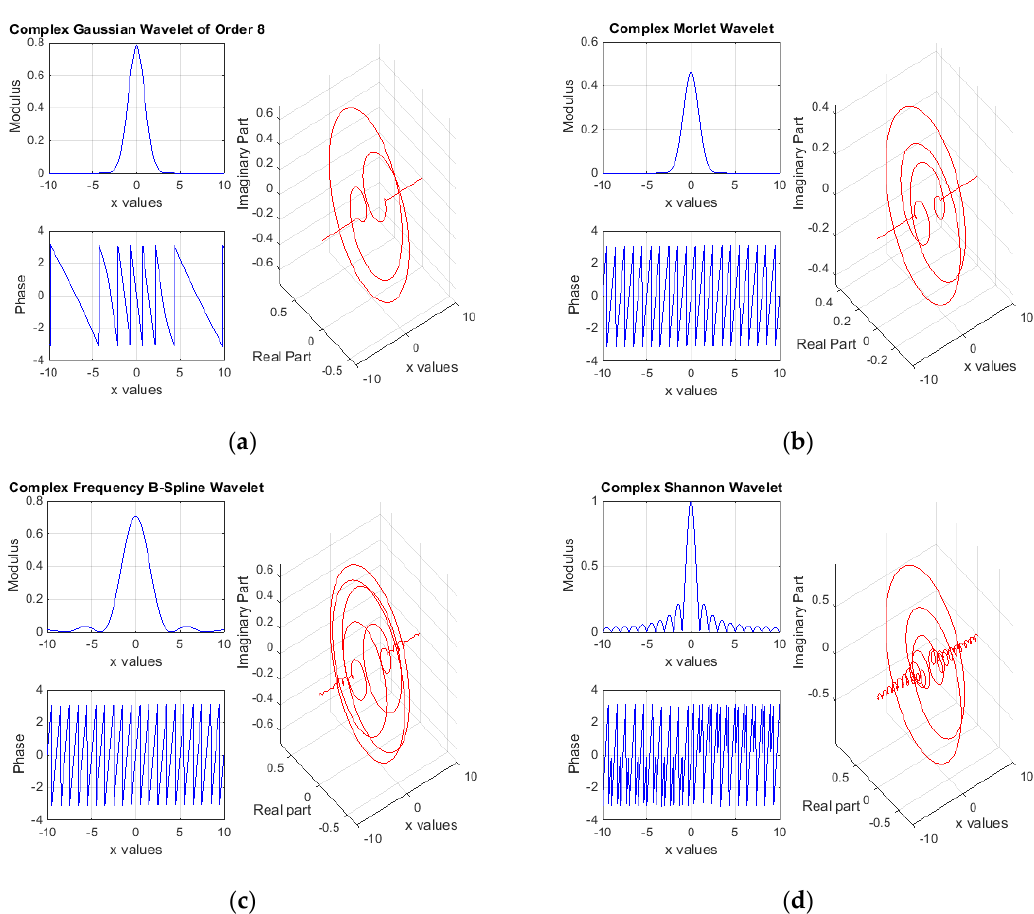
(15) with a denoting the scaling parameter and b the translation parameter. In Equation (15), Ψ denotes the basic wavelet function and superscript symbol (*) indicates the complex conjugate. The wavelet